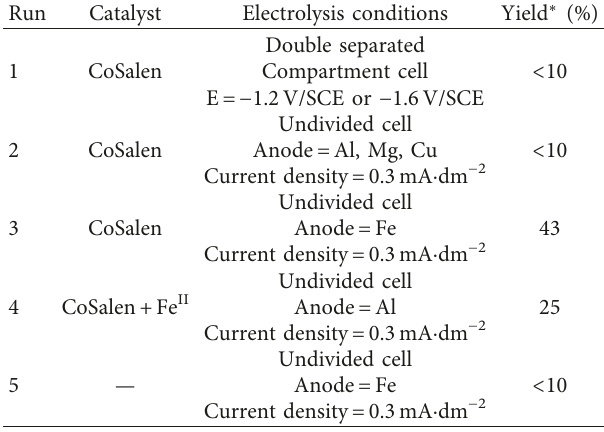
Table 5: Results of the conjugate addition of 2-bromooctane to methylvinylketone, catalyzed by Co I Salen − , in DMF solution and with various electrolysis